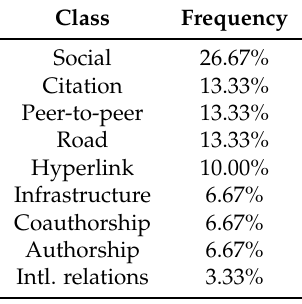
Table 2. Network class frequency of the data set in Table